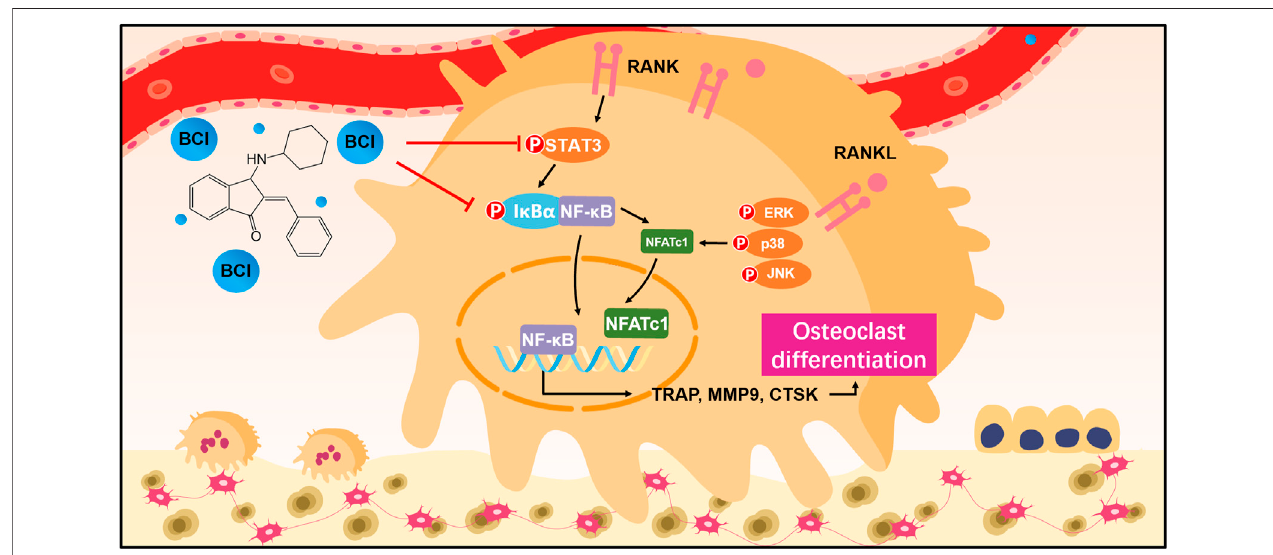
FIGURE 9 | Schematic showing BCI-mediated regulation of RANKL-induced osteoclast differentiation and amelioration of OVX-induced osteoporosis.